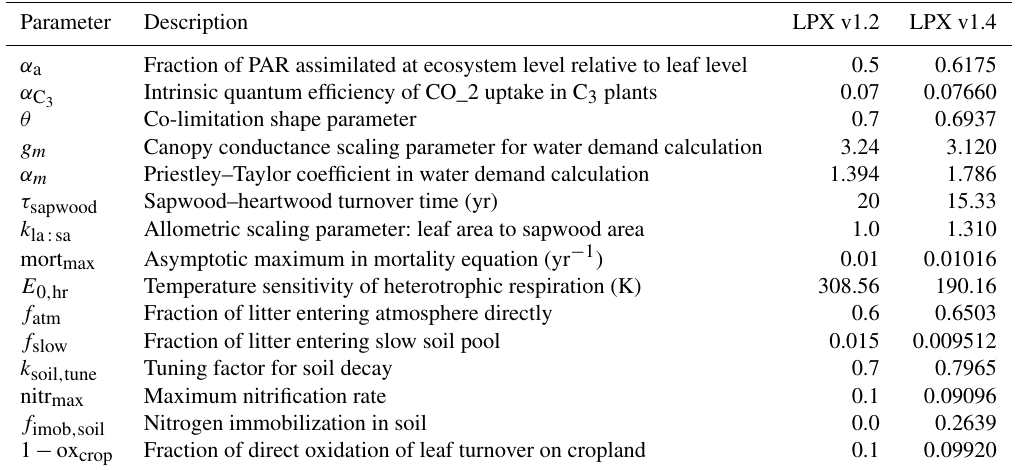
Table 1. Description of sampling parameters with values for LPX v1.2 and the new best-guess version 1.4. If not otherwise indicated parameters are